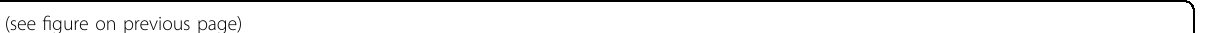
Fig. 1 CUDC-907 treatment induces a time- and concentration/dose-dependent downregulation of FLT3 in FLT3-ITD AML cell lines through proteasome-dependent mechanism. A FLT3-ITD AML cell lines MOLM-13 and MV4-11 were treated with CUDC-907 for 4, 8, 12, or 24 h, at variable concentrations. Western blots were generated utilizing whole-cell lysates. Representative blots are shown. Densitometry measurements, normalized to β -actin and compared to vehicle control, are displayed below the corresponding blot. B FLT3-ITD AML cell lines MOLM-13 and MV4-11 were treated with CUDC-907 and/or Z-VAD-FMK (Z-VAD) for 24 h. Western blot analyses of FLT3 and cleaved-caspase 3 (cf-caspase 3) were performed. Densitometry measurements, normalized to β -actin and compared to vehicle control, are displayed below the corresponding blot. C Primary FLT3-ITD positive AML patient sample AML#208 was treated with CUDC-907 for 24 h at variable concentrations. Western blots were generated utilizing whole-cell lysates. Representative blots are shown. Densitometry measurements, normalized to β -actin and compared to vehicle control, are displayed below the corresponding blot. D MV4-11 xenograft models were treated once with CUDC-907 at doses of 100 or 150 mg/kg. After 24 h, mouse bone marrow cells were collected and human CD45 + cells were enriched. Whole-cell lysates were subjected to western blotting. Densitometry measurements, normalized to β -actin and compared to vehicle control, are displayed below the corresponding representative blot. E FLT3-ITD AML cell lines MOLM-13 and MV4-11, a primary FLT3-ITD positive AML patient sample, and the murine MV4-11 xenograft models were treated with CUDC-907 for 24 h. Total RNA was extracted, and real-time RT-PCR was performed. The relative changes in FLT3 transcripts, normalized to GAPDH, in comparison to control samples were quanti fi ed. The displayed results represent the mean of three independent experiments, with fold changes calculated via the comparative Ct method and normalized to GAPDH transcripts. * p < 0.05, ** p < 0.01, *** p < 0.001, and ns indicates not signi fi cant compared to vehicle control. F MOLM-13 cells were treated with CUDC-907 for 12 h, washed, and then treated with cycloheximide for up to 3 h. Western blots were generated utilizing whole-cell lysates. The FLT3 densitometry fold changes were assessed (comparison to vehicle control and normalized to β -actin). Representative blots are shown on the left side, while densitometry measurements are graphed on the right. * p < 0.05 compared to vehicle control. G FLT3-ITD AML cell lines MOLM-13 and MV4-11 were treated with CUDC-907 alone or in combination with the proteasome inhibitor MG-132 for 24 h. Western blot analyses of FLT3 were performed, with densitometry results compared to vehicle control and normalized to β